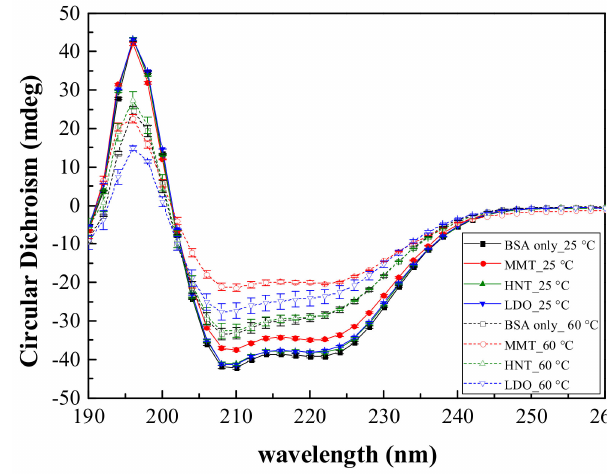
Figure 7. CD spectra of BSA with MMT, HNT and